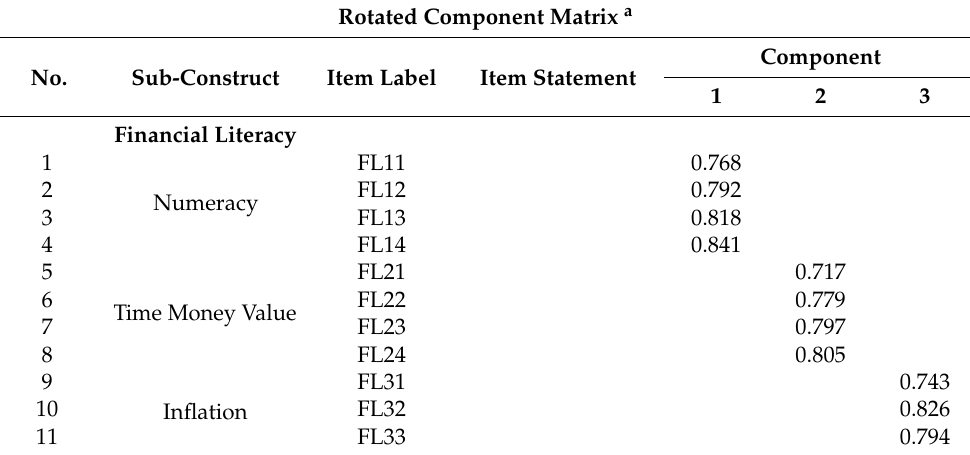
Table 2. Items retained for Financial Literacy